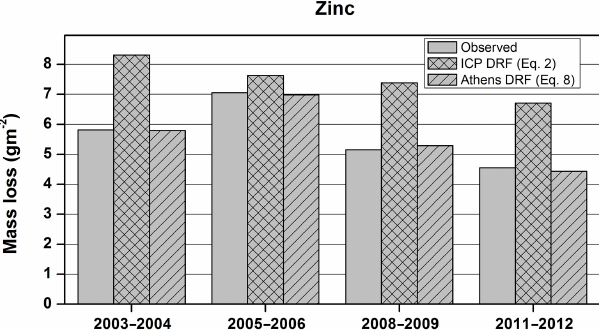
Figure 8. Experimental obtained mass loss values at Athens, Greece for the case of zinc along with the predicted values by